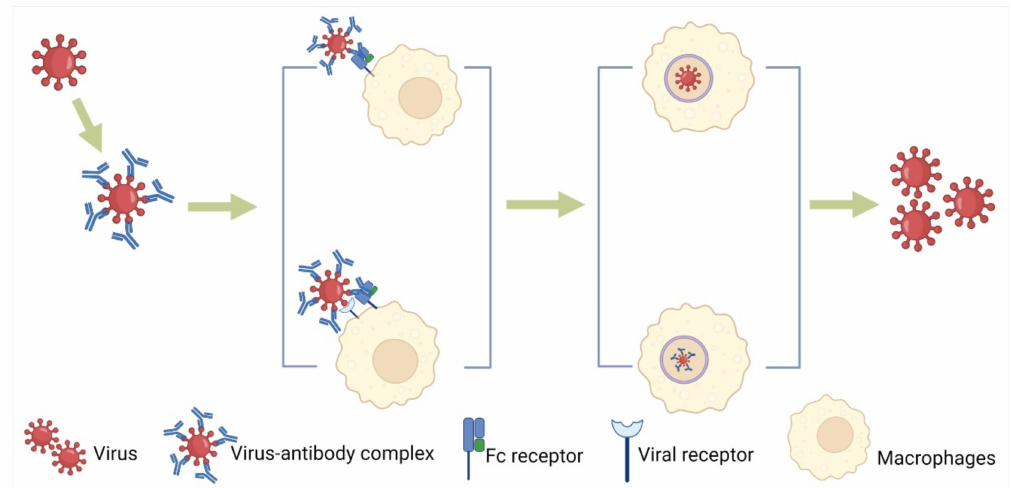
Figure 1. Facilitating virus entry into the target cells with or without viral receptors through en- docytosis or micropinocytosis. There are two modes of FcR-mediated virus entry, one in which the virus–antibody complex only relies on the FcR on the surface of macrophages to mediate the endocytosis or micropinocytosis and one that requires the participation of the virus